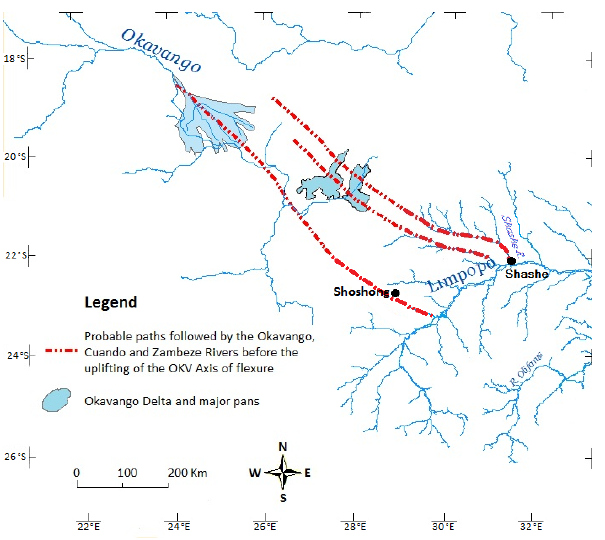
Figure 8. Flood risk map of the Shoshong settlement, Botswana (source: Maló and Da Conceição, 2007).